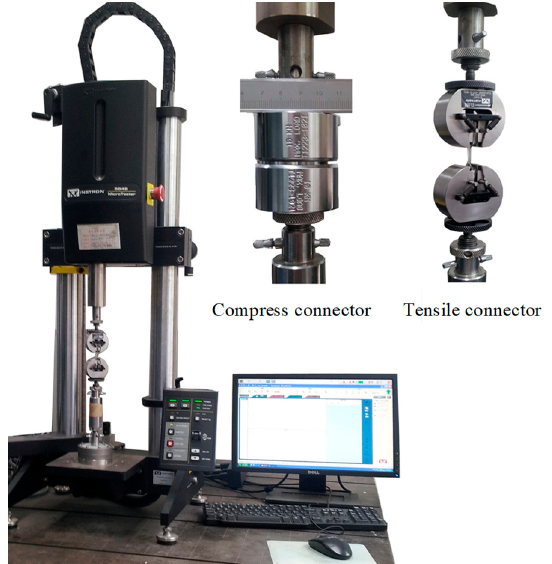
Figure 3. Schematic diagram of testing machine and compress/tensile connector.